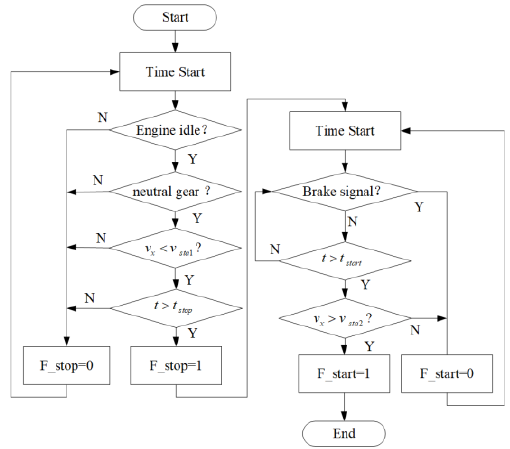
Figure 4. Flowchart of vehicle start state discrimination.